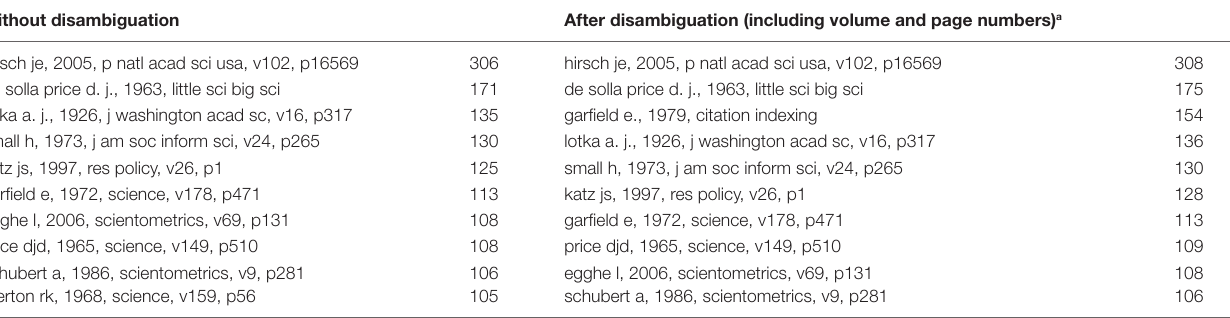
TaBle 2 | Ten most-cited publications in Scientometrics (before and after machine disambiguation using crexplorer); January 2,